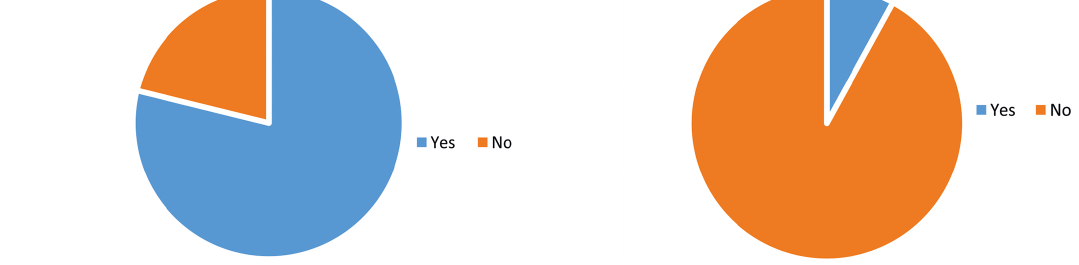
Figure 7. Representative pie charts on the students’ responses. The students were asked to select an answer amongst a list of